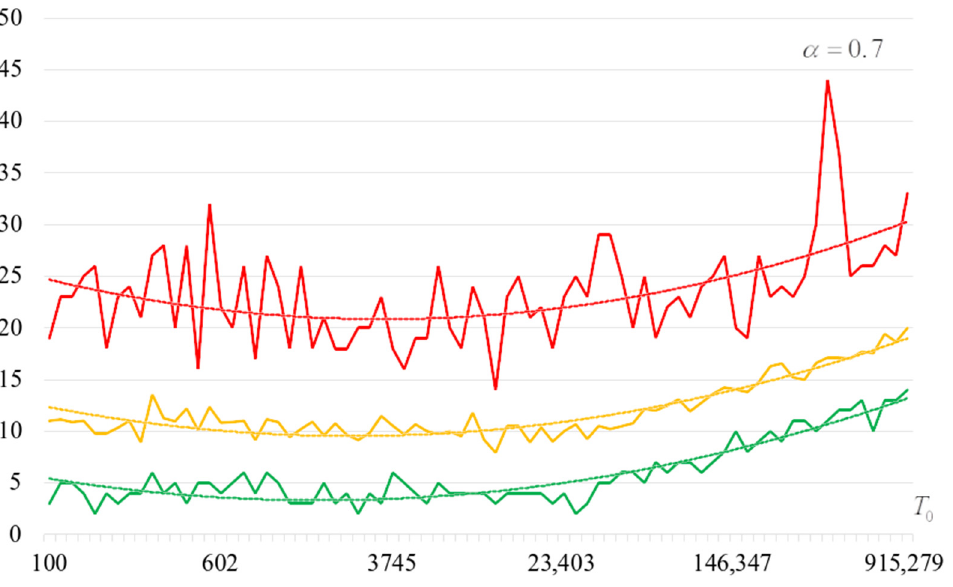
Figure 15. The dependencies of the number of iterations of the outer loop (until one of the criteria for stopping the algorithm is fulfilled) if the algorithm is successfully started, 𝛼 = 0.7 .